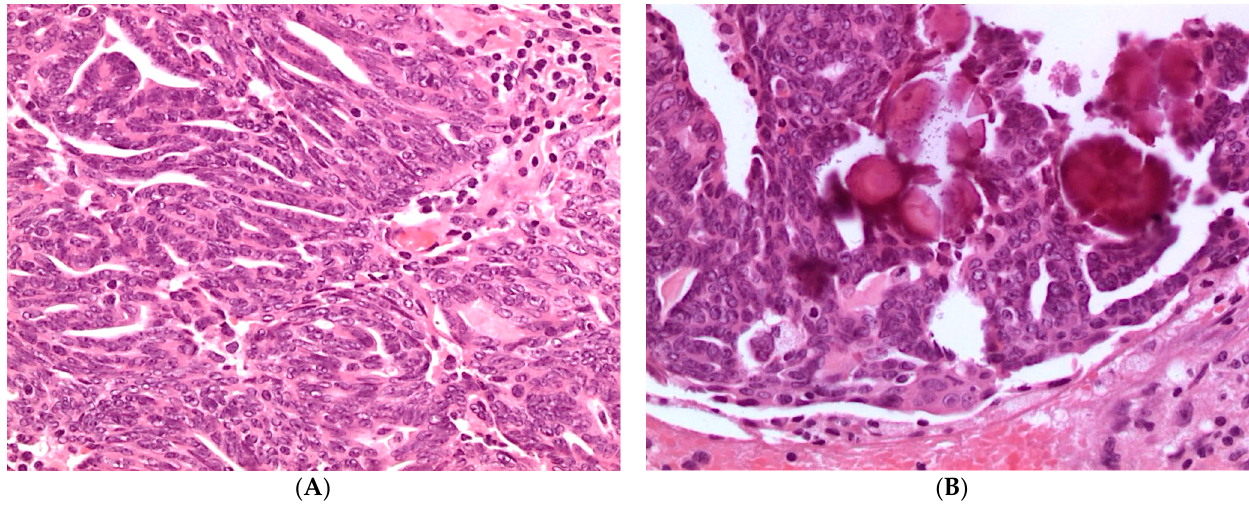
Figure 2. ( A ) Histologic appearance of low-grade serous carcinoma showing tumor cells with uniform nuclei and incon- spicuous mitotic activity (hematoxylin and eosin, H&E, ×100); ( B ) Psammoma bodies are frequent in low-grade serous carcinoma (hematoxylin and eosin, H&E, ×100).